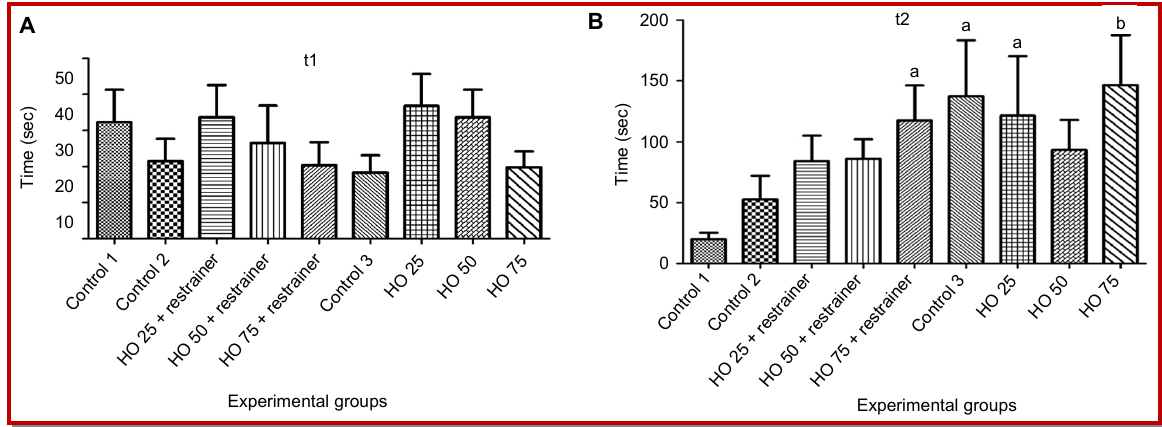
Figure 1: Duration of initial (A) and secondary (B) latency in passive avoidance memory test. All groups are compared with con- trol group 1. a Significant difference compared to control Group 1 (p<0.05); b significant difference compared to control Group 1 (p<0.01); HO: Hyssopus officinalis